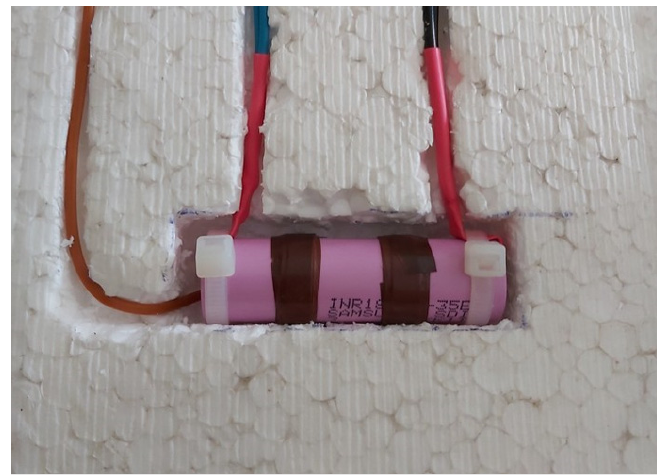
Figure 8. Samsung INR18650-35E tested in the insulation layer.